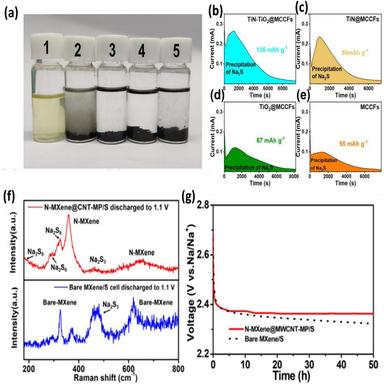
a) Photographs of polysulfide with the addition of MCCFs, TiN@MCCFs, TiNeTiO2@MCCFs, and TiO2@MCCFs and b-e) the corresponding potentiostatic discharge curves of Na2S6/EC/PC solution on various surfaces. Reprinted (adapted) with permission from . Copyright 2021 American Chemical Society. f) Raman spectra of Ne N-doped Ti3C2Tx MXene microsphere and Ti3C2Tx incorporated sulfur cathodes after 1000th cycle, g) self-discharge static test of N-MXene@MWCNT-MP/S coin cell. Reprinted (adapted) with permission from